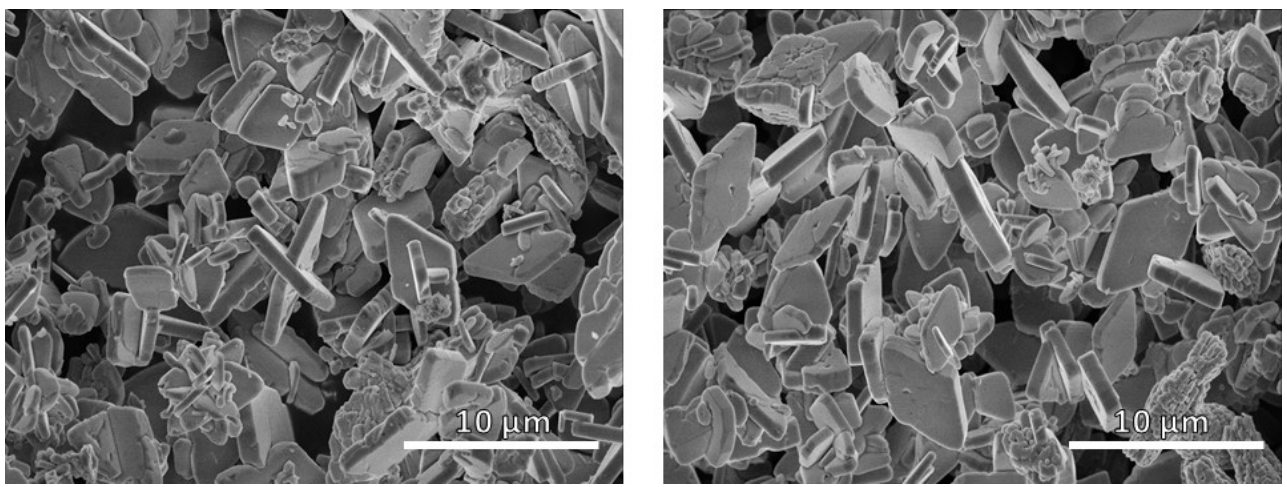
Figure 4. SEM micrographs of the synthesized base LiFePO 4 obtained from the HS base experiment (two random areas of the sample are displayed).